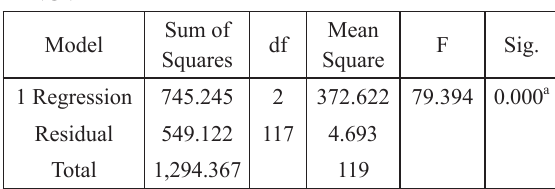
Summary Model for Trialability and